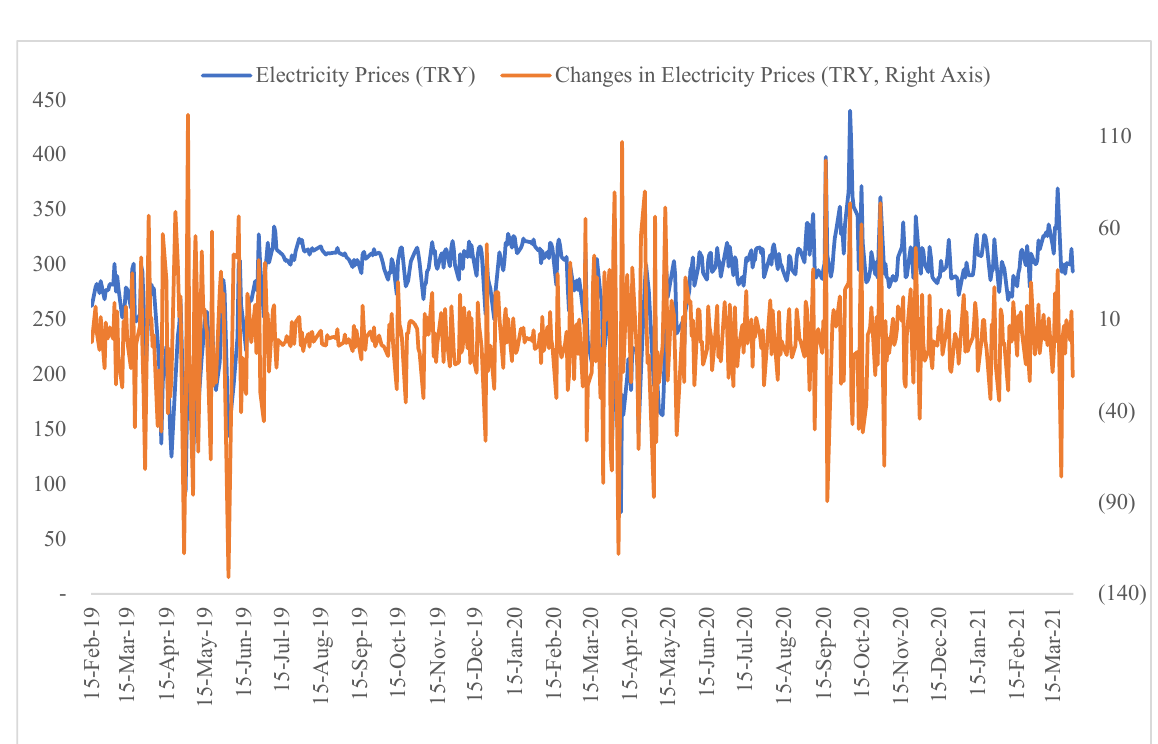
Figure A1. The progress of electricity p rices in Turkey.